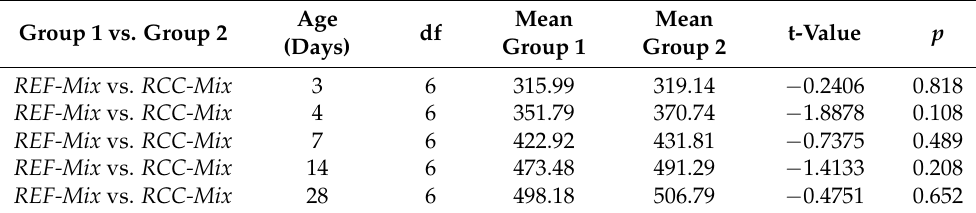
Table 16. Results of separate t -test results comparing the REF-Mix and RCC-Mix at different ages in terms of UCS